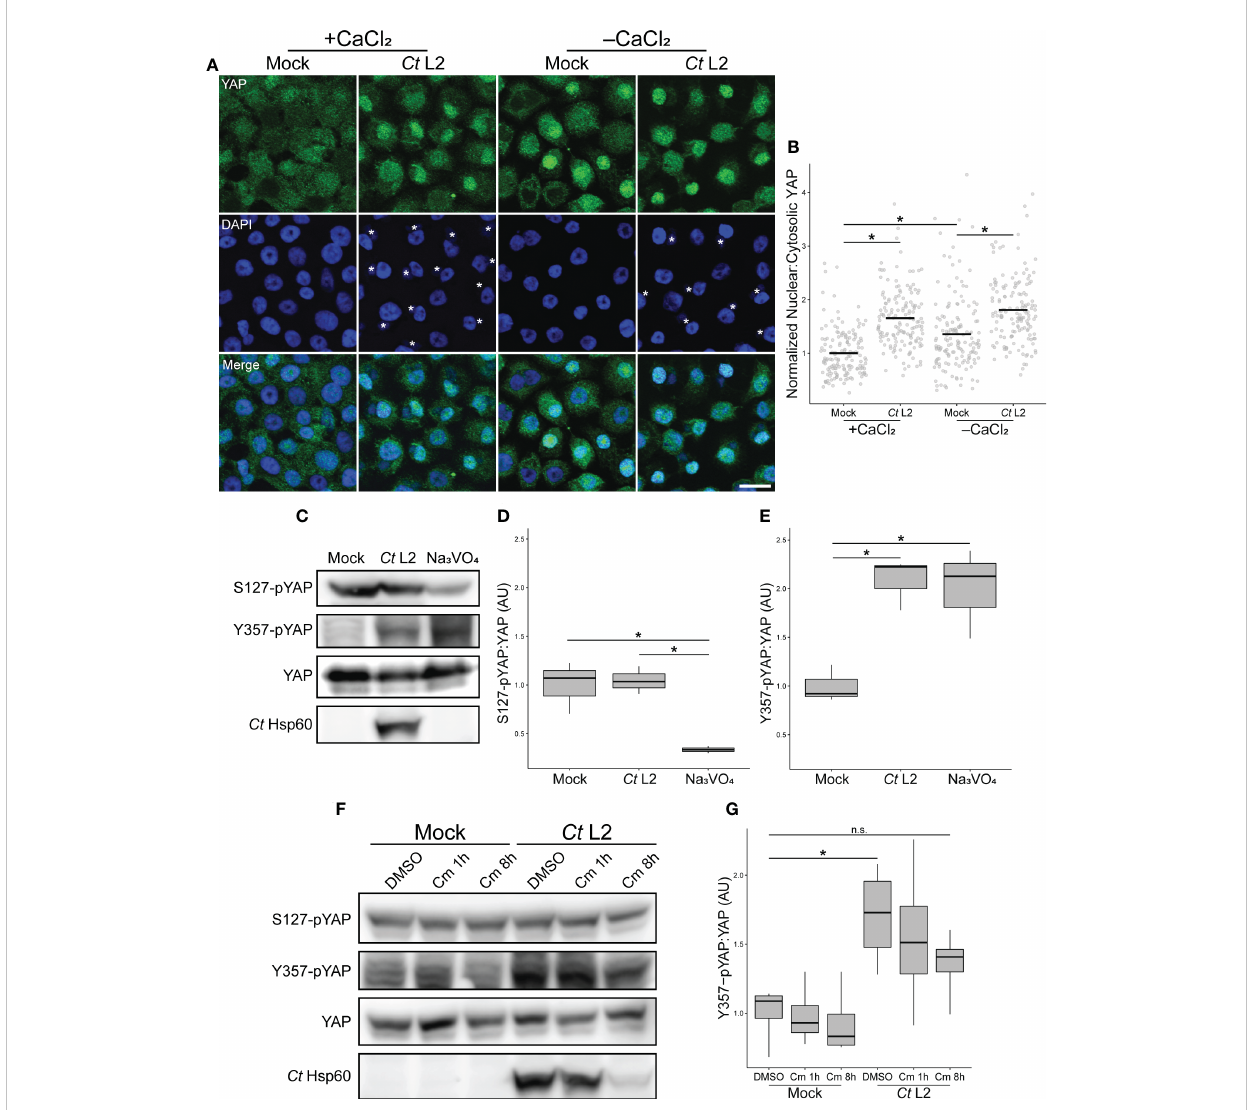
FIGURE 3 Chlamydia infection bypasses Hippo-mediated YAP inhibition by enhancing YAP phosphorylation at Y357. (A) Representative micrographs of YAP translocation (green) into the nuclei (blue) of con fl uent mock- and Ct L2-infected End1 cells at 24 hpi, cultured in calcium-replete (+CaCl 2 , 0.4 mM) or calcium-deplete (-CaCl 2 ) keratinocyte serum-free media. Asterisks: chlamydial inclusions, scale bar: 20 m m. (B) Quanti fi cation of YAP nuclear translocation in (A) as a ratio of nuclear to cytosolic YAP fl uorescence. n = 3 biological replicates, with a minimum of 5 fi elds measured per sample. Black bars: group means; asterisks: p-values ≤ 0.05, using pairwise Wilcoxon rank sum tests and Bonferroni ’ s correction for multiple comparisons. (C) Representative Western blot of YAP phosphorylation of mock- and Ct L2-infected or sodium orthovanadate-treated (Na 3 VO 4 , 10 mM for 1 h at 23 hpi) End1 cells at 24 hpi. (D, E) Densitometric quanti fi cation of YAP phosphorylation at S127 (D) and Y357 (E) , normalized to total YAP. n = 3 biological replicates; whiskers: minimum to maximum; asterisks: p-values ≤ 0.05, using pairwise Student ’ s t-tests and Bonferroni ’ s correction for multiple comparisons. (F) Representative Western blot of YAP phosphorylation of mock- and Ct L2-infected and DMSO or chloramphenicol-treated (Cm, 50 ug/mL for 1 h at 7 hpi or 8h at 10 hpi) End1 cells at 18 hpi. (G) Densitometric quanti fi cation of YAP Y357 phosphorylation, normalized to total YAP. n = 3 biological replicates; whiskers: minimum to maximum; n.s.: not signi fi cant (p-values > 0.05), asterisks: p-values ≤ 0.05, using pairwise Student ’ s t-tests and Bonferroni ’ s correction for multiple